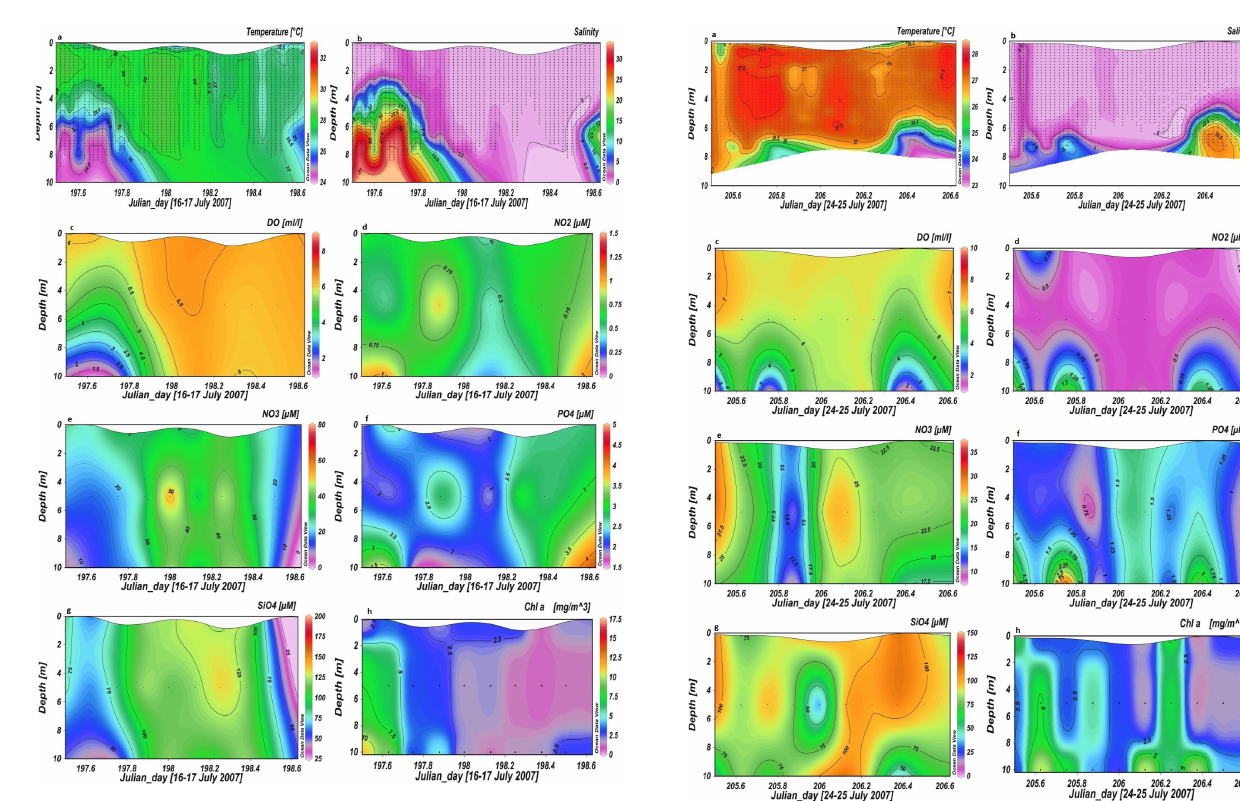
Fig. 7. Depth–time contours of salinity, temperature DO, chloro- phyll a , NO 2 , NO 3 , PO 3 , SiO 4 for every three hours from surface, 4 4 mid-depth and bottom during neap tide of wet